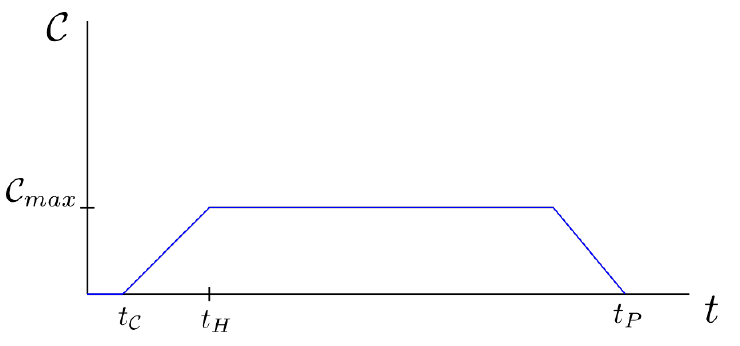
Figure 5 . Scheme for complexity pattern of a (cid:12)nite d black